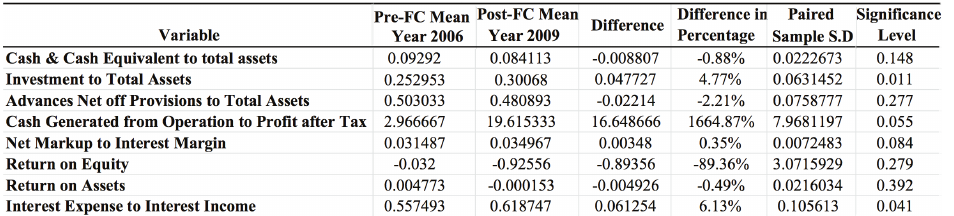
Paired Sample T-test of Different Ratios for the Year 2006 and